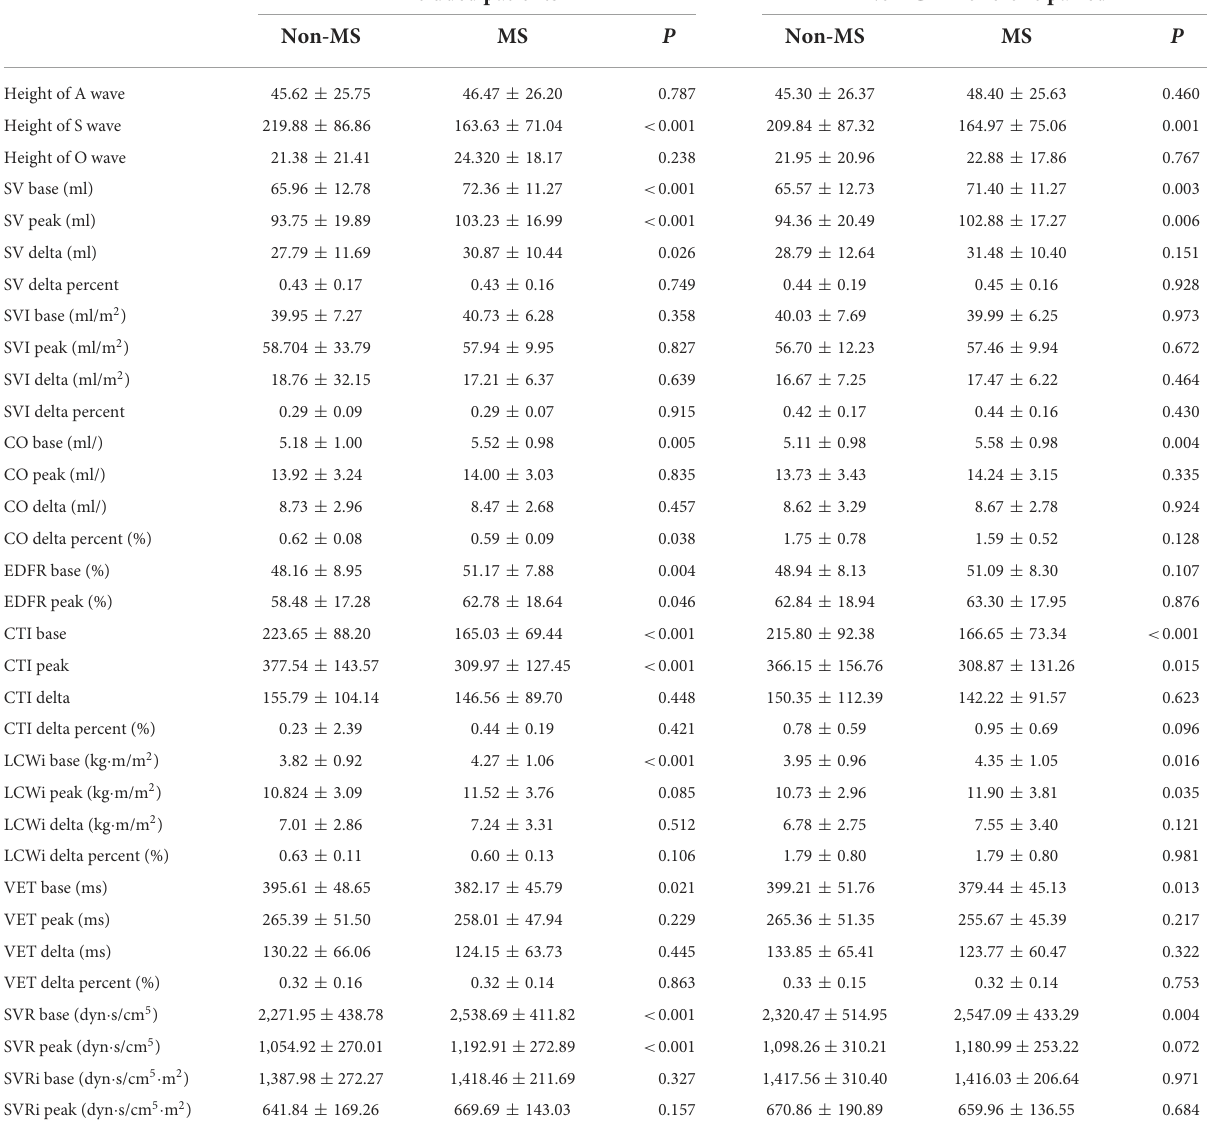
TABLE 3 The figures of high-definition impedance cardiography of included patients and non-CHD one-one paired. Included